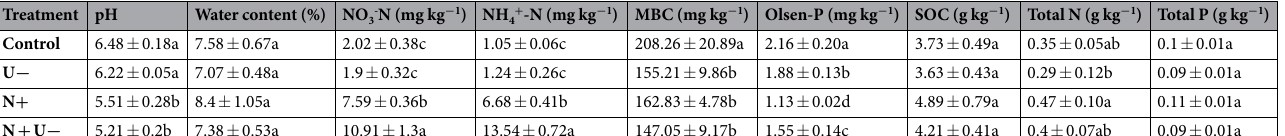
Table 1. Soil properties as influenced by N addition and understory removal in a Mongolian pine plantation. Values are means ± standard error, n = 4. Different letters within each column indicate significant differences ( P < 0.05), according to the LSD post-hoc test following one-way ANOVA. Control control plots, U − understory removal, N + N addition, N + U − N addition with understory removal. MBC microbial biomass C, SOC soil organic